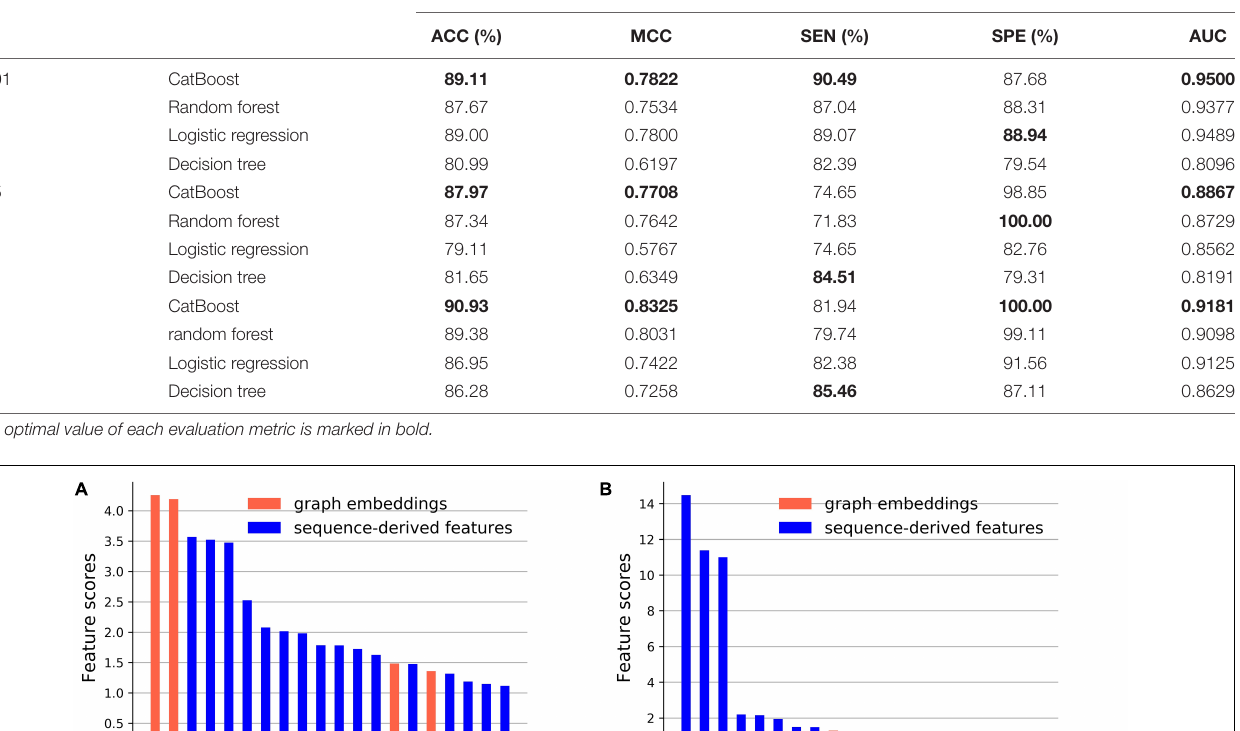
TABLE 3 | The performance of different classifiers.